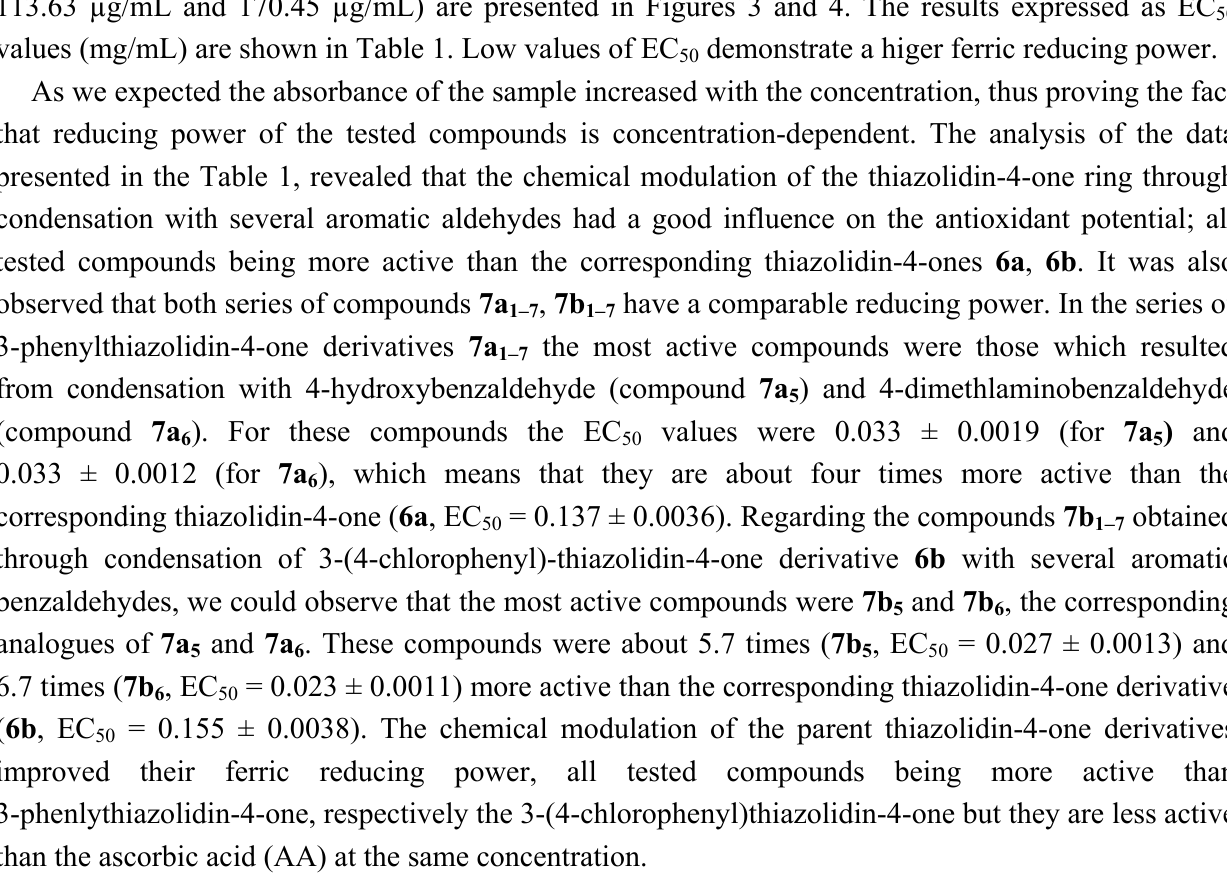
Figure 3. The absorbance of 7a